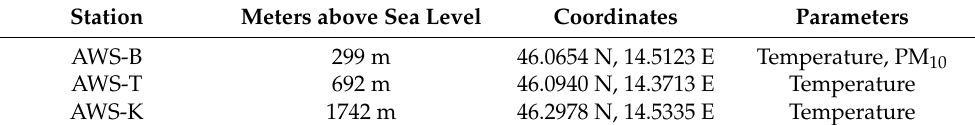
Table 1. Automatic weather stations (AWS) used to determine ATIs, their locations, elevations, and parameters collected.